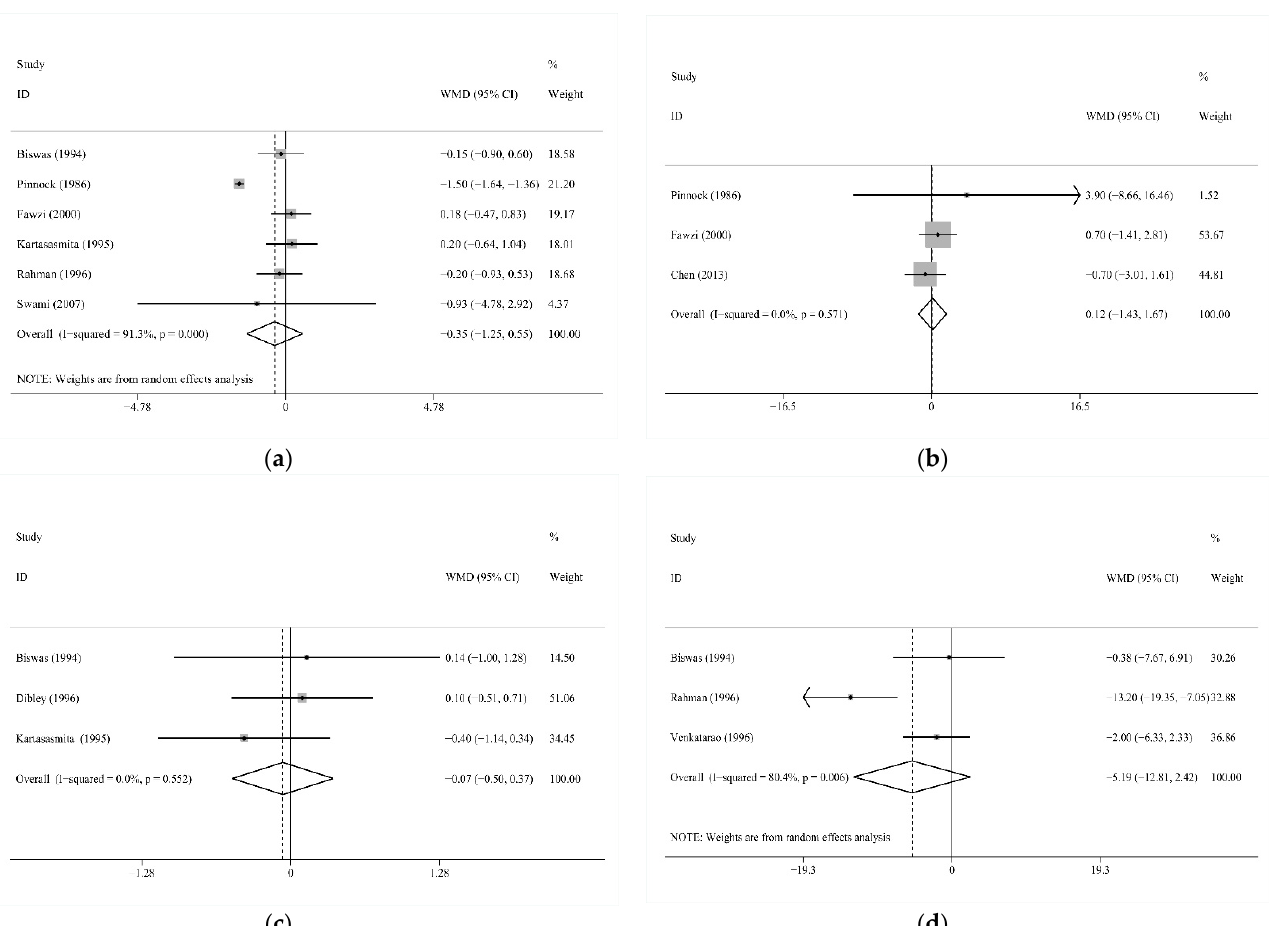
Figure 3. ( a ) Comparison of Vitamin A versus Control, Outcome 2—Mean number of episodes/child-year of acute respiratory tract infection (ARTI) at longest follow-up; ( b ) Comparison of Vitamin A versus Control, Outcome 3—Mean cough days of acute respiratory tract infection (ARTI) at longest follow-up; ( c ) Comparison of Vitamin A versus Control, Outcome 4—Mean duration of episodes due to acute respiratory tract infection (ARTI) at longest follow-up; ( d ) Comparison of Vitamin A versus Control, Outcome 5—Mean duration per child due to acute respiratory tract infection (ARTI) at longest follow-up; WMD: weighted mean difference.